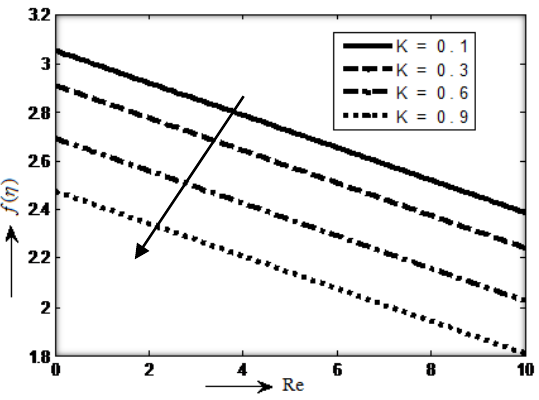
Figure 12. Variation of fluid velocity f (  ) against Re for permeability parameters K (0.1, 0.3, 0.6, 0.9) by taking parameters  = 1.6, M = 2 and  =